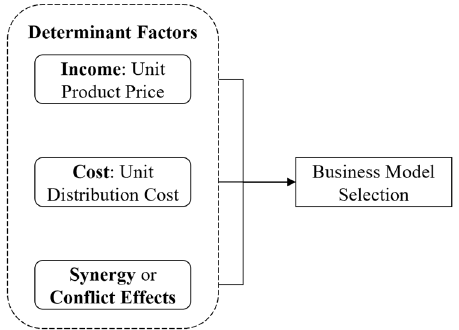
Figure 1. Factors determining the retailing enterprise business model selection.